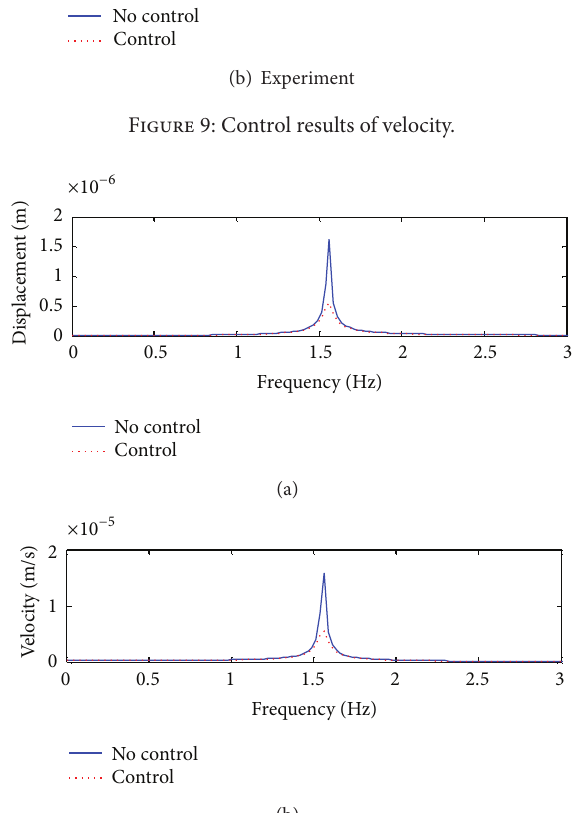
Figure 10: Spectrum analysis of control results in simulation.